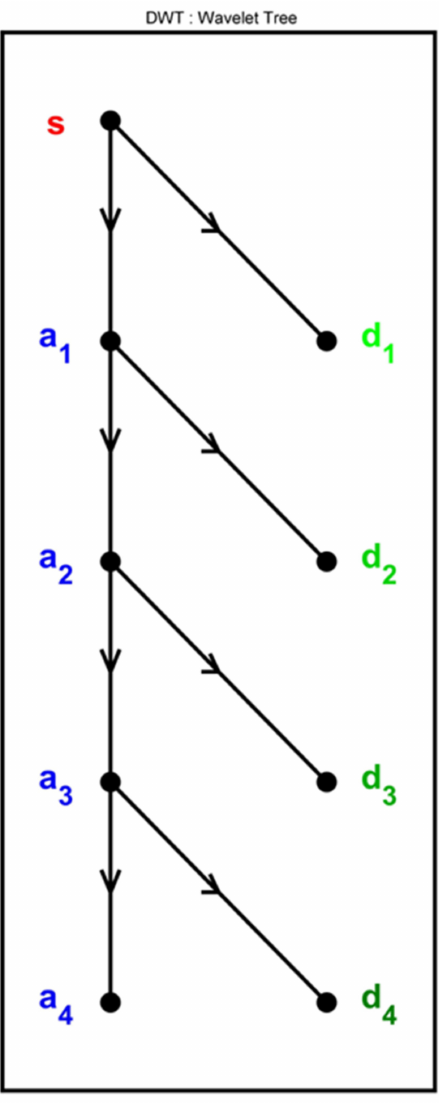
Figure 4. Four-level wavelet decomposition. Source: Own elaboration based on MATLAB & Simulink